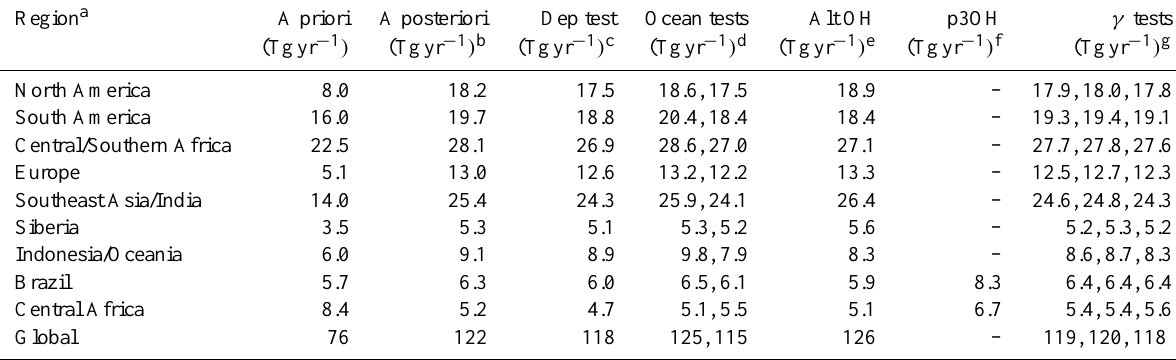
Table 2. Optimization of terrestrial methanol emissions based on the TES measurements. Region